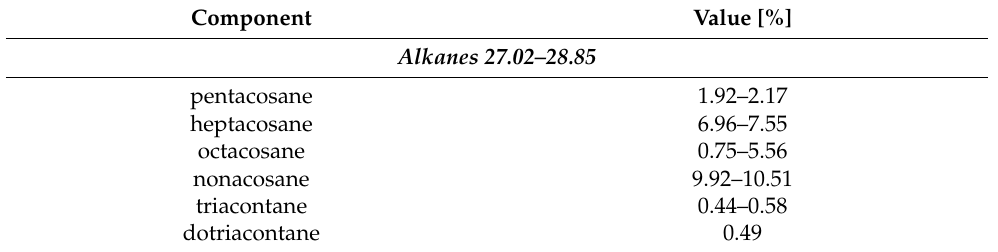
Table 3. The content of the fraction in the entire mass of the hemp